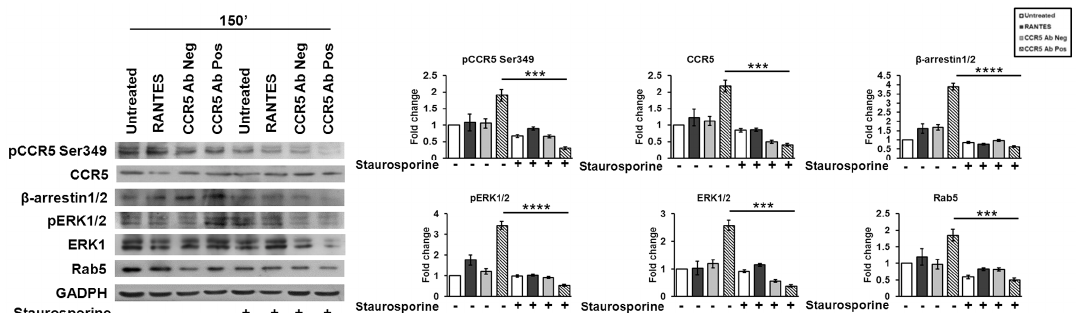
Figure 3. Contribution of phosphorylation activity in the CCR5 regulation. After 1 h of pre-treated with staurosporine (50 nM), R5-SupT1-M10 cells were stimulated, or not, with CCR5 Ab Pos, RANTES (positive control) and CCR5 Ab Neg (negative control). The cells were harvested at 150 min (30 min incubation, wash, additional 120 min incubation in medium without stimuli). Western blot analysis from total extracts were performed to evaluate phosphorylated and non-phosphorylated forms of CCR5 and ERK1, β -arrestin1/2, and Rab5. Band density was determined with the TINA software (version 2.10, Raytest, Straubenhardt, Germany) and it is shown as fold change over a housekeeping gene. Bar graphs represented mean ± SD of three independent experiments. Student’s t -test was performed and p -values are shown. * p ≤ 0.05, ** p ≤ 0.01, *** p ≤ 0.001, **** p ≤ 0.0001. Data are representative of three independent experiments.